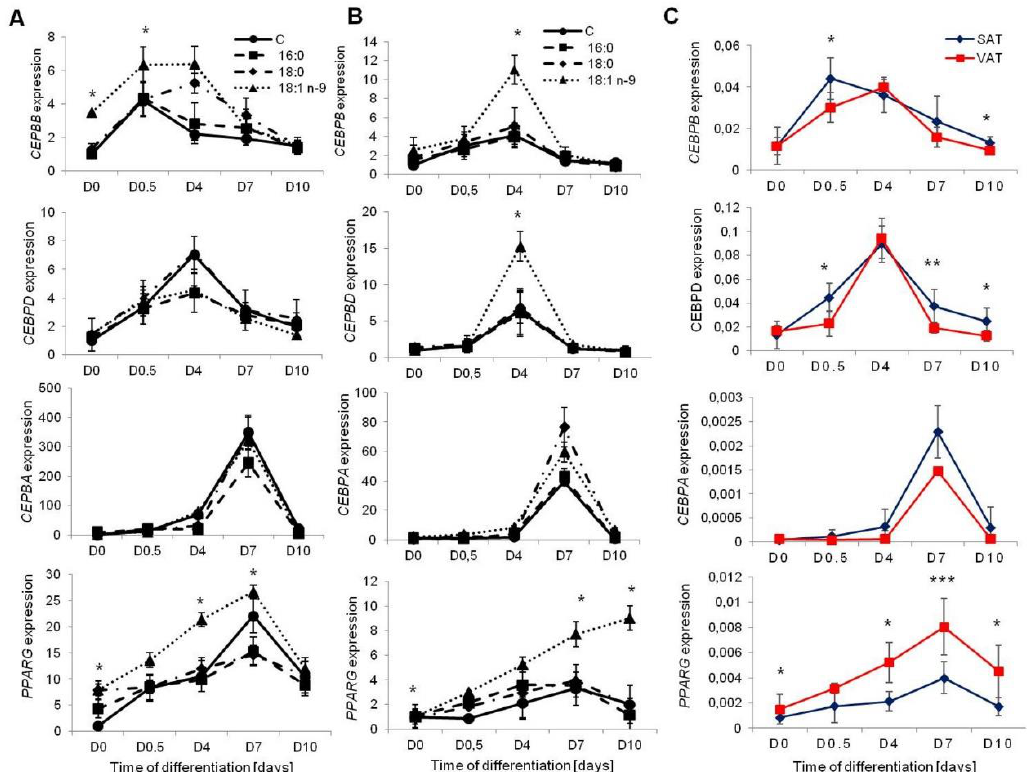
Figure 3. The expression of adipogenic transcription factors. Early transcription factors (CCAAT enhancer binding protein β ( CEBPB ), CCAAT enhancer binding protein β ( CEBPD )) and late transcription factors (CCAAT enhancer binding protein α ( CEBPA ), peroxisome proliferator activated receptor γ ( PPARG )) in SAT ( A ), VAT ( B ) in adipocytes treated with palmitic acid (16:0), stearic acid (18:0), oleic acid (18:1n − 9) and control cells during adipogenesis, normalization was done to the day 0 (D0). Expression of transcription factors between SAT and VAT ( C ); * p < 0.05, ** p < 0.001, *** p < 0.0001.